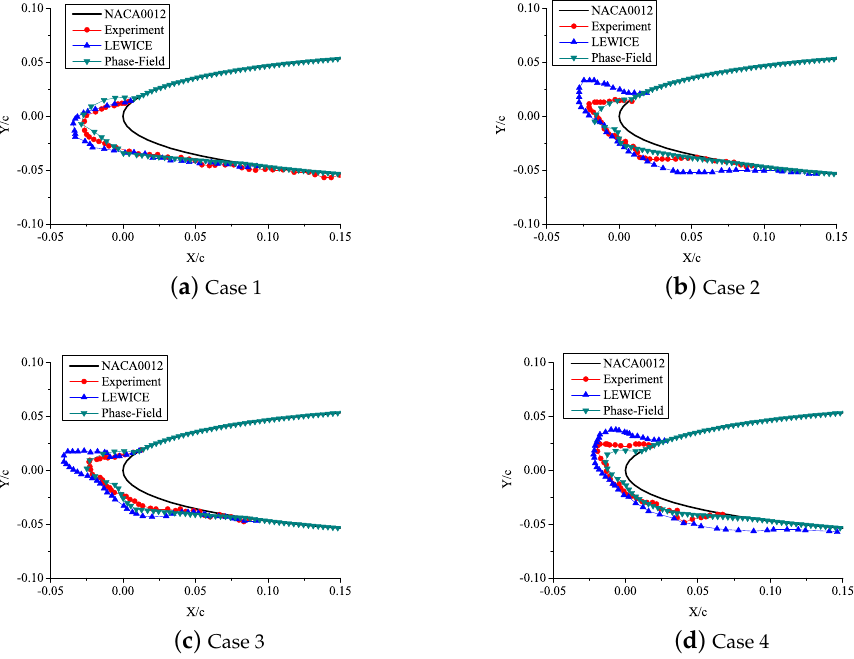
Figure 8. Comparison of the ice shapes under different verification